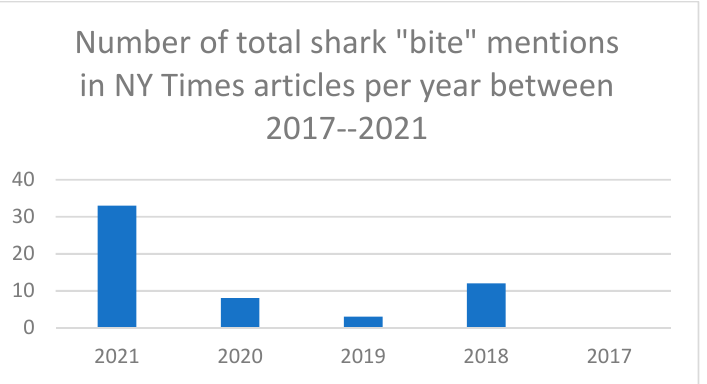
Figure 5. Contains data on the number of total shark “bite” mentions in NY Times articles per year between 2017–2021.